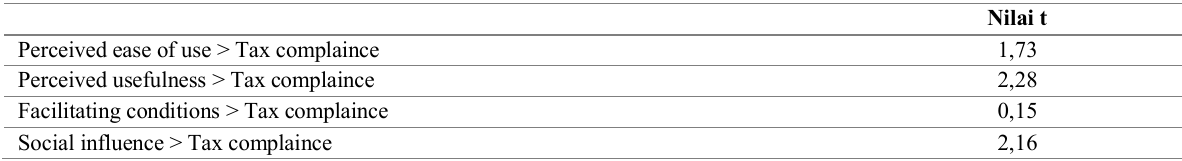
Table 2: Total Effect